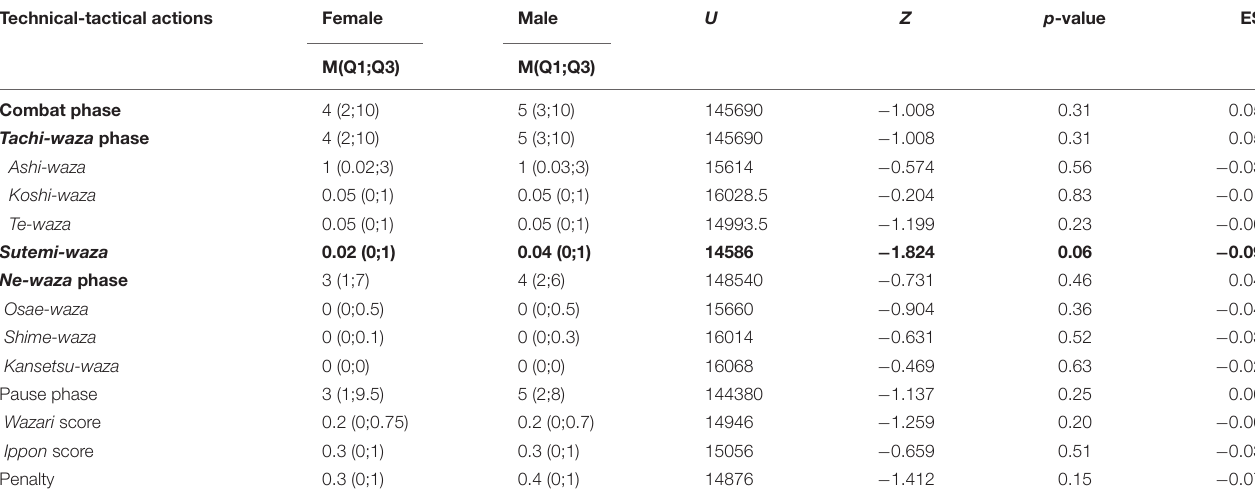
TABLE 2 | Comparisons of technical-tactical behaviors judo combat of female versus male cadets (frequencies). Technical-tactical